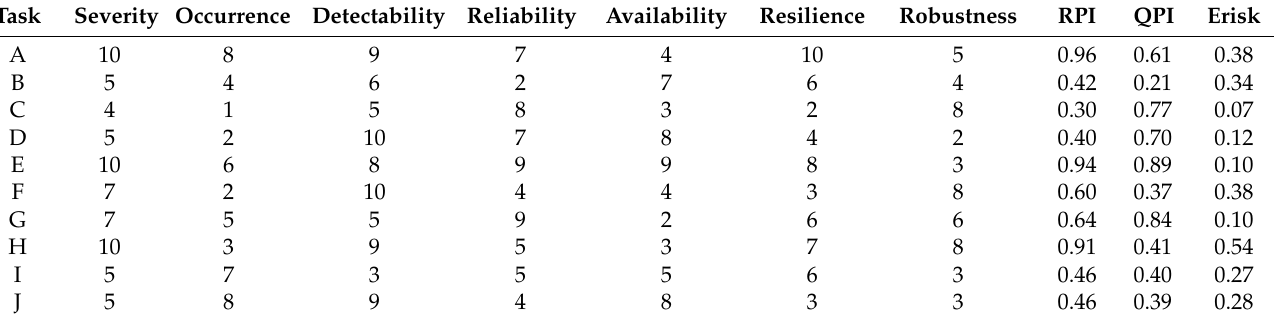
Table 6. Effective risk assessment of team 1 in each project